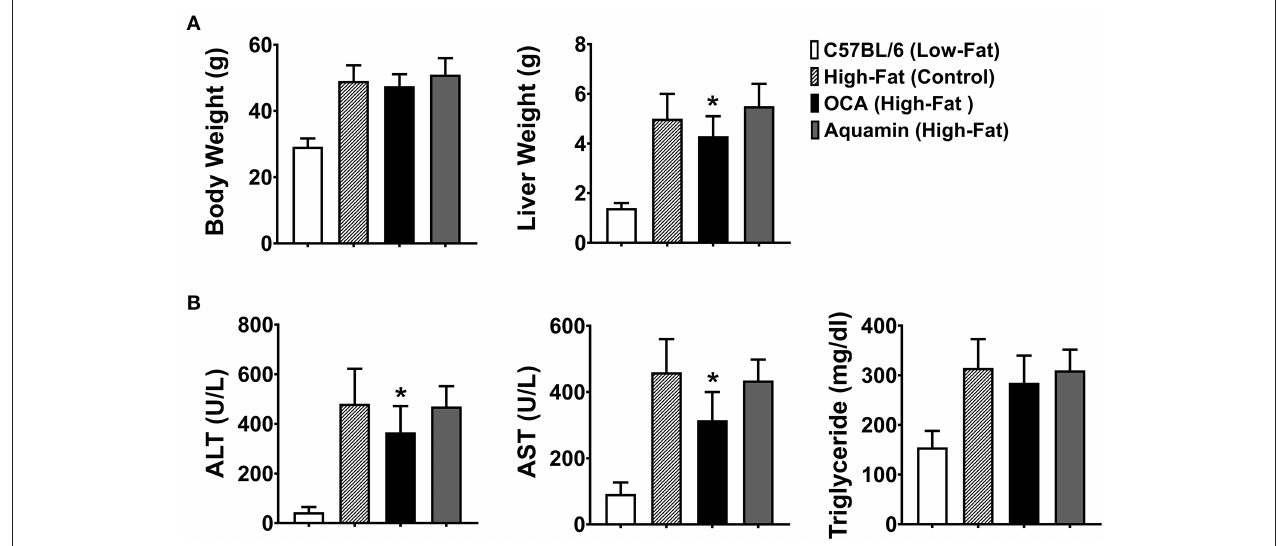
FIGURE 1 | Whole-body weight, liver weight and biochemical markers. (A) Whole-body weight and liver weight were obtained for each animal at euthanasia. (B) Blood was obtained by cardiac puncture at euthanasia and assessed for ALT, AST, and triglyceride levels. Values shown are means and standard deviations based on nine animals per group. Statistical significance was assessed by ANOVA followed by a two-tailed t -test. Asterisks (*) indicate statistical difference from high-fat control at p < 0.05. With all five parameters, low-fat control values were statistically different from high-fat control at p < 0.05.